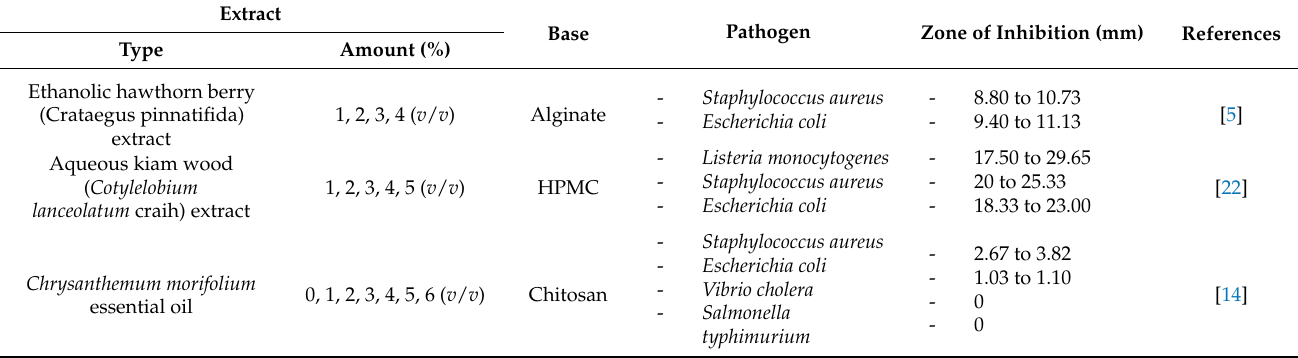
Table 3. Antibacterial activity of various APE and EOs-incorporated EFs against different pathogens. Extract Base Pathogen Zone of Inhibition